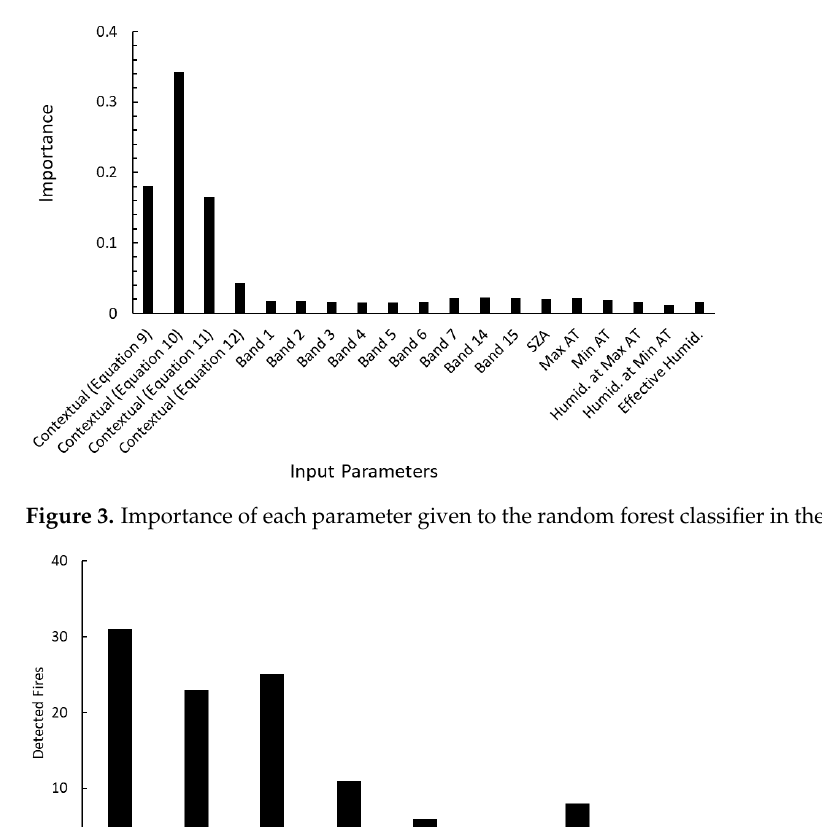
Figure 3. Importance of each parameter given to the random forest classifier in the proposed method.